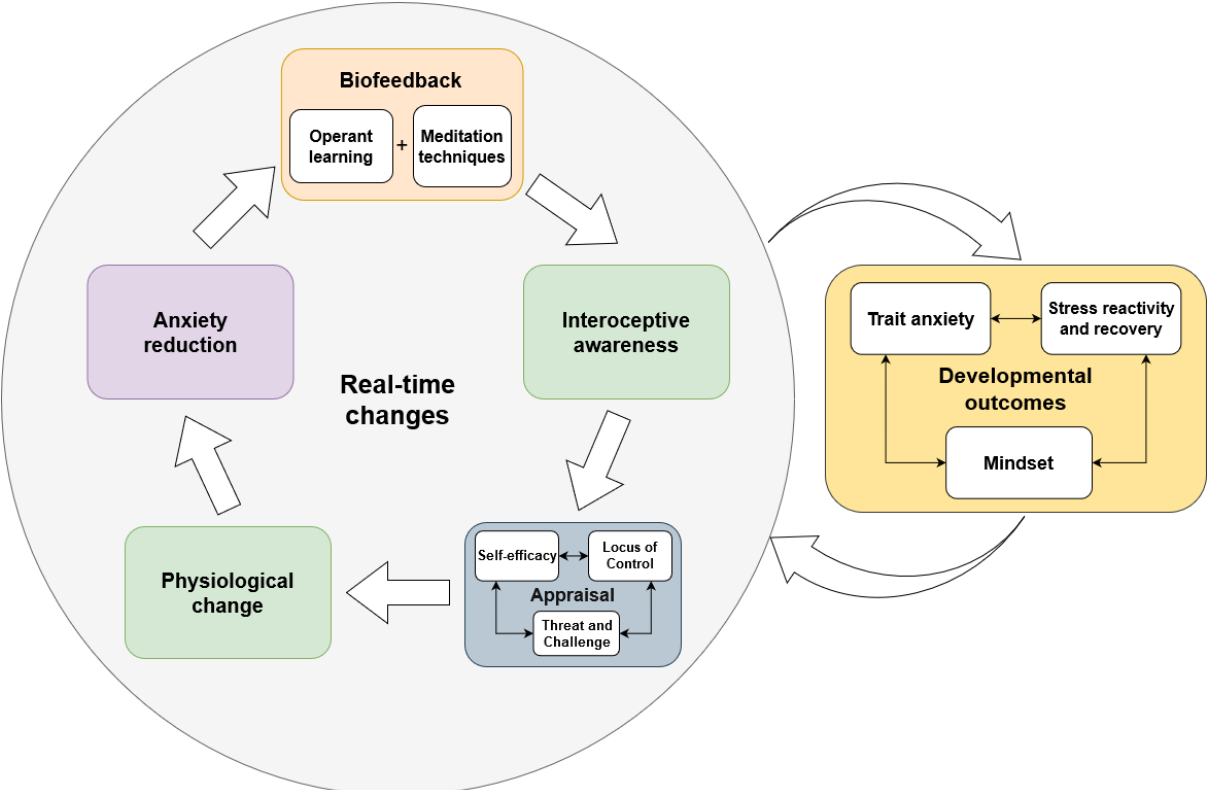
Figure 3. Model of developmental change showing repeated practice leading to changes in mindset, stress reactivity and recovery, and a trait proclivity to feel